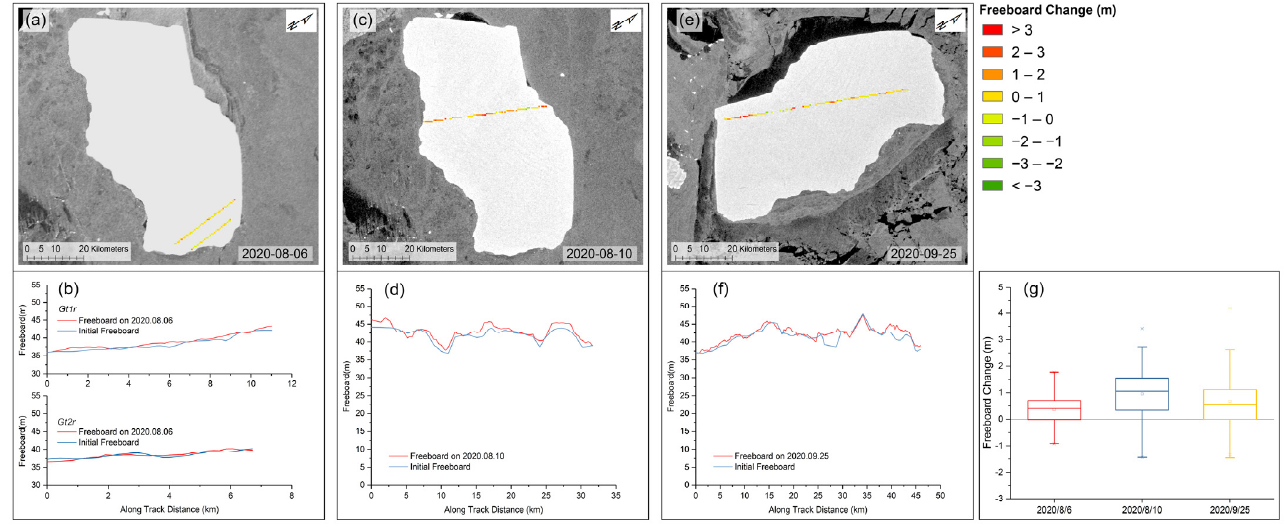
Figure 9. The altimeter ground tracks mapped on the iceberg surface on 6 August ( a ), 10 August ( c ), and 25 September ( e ) of 2020, and the corresponding freeboard differences along the tracks ( b ),( d ), and ( f ), respectively. ( g ) The box plot of freeboard differences.